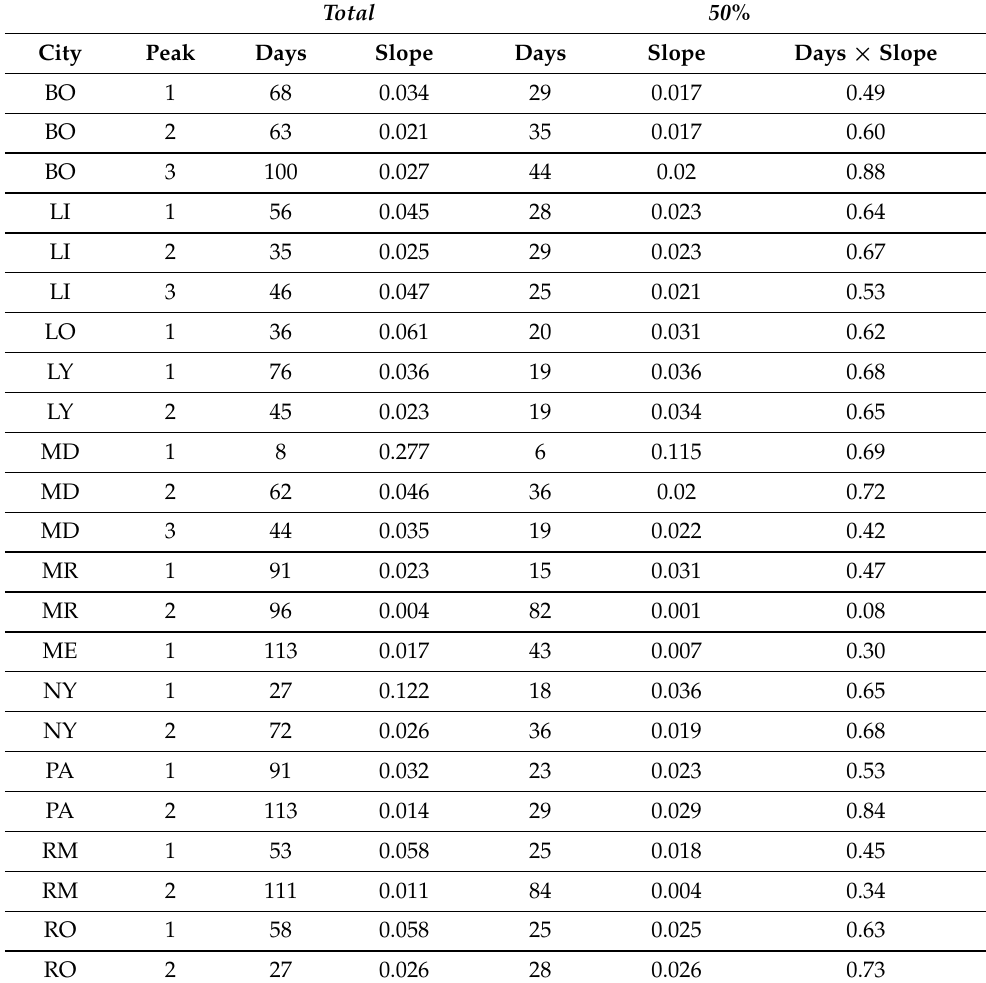
Table 5. Upward slopes for total and 50 %